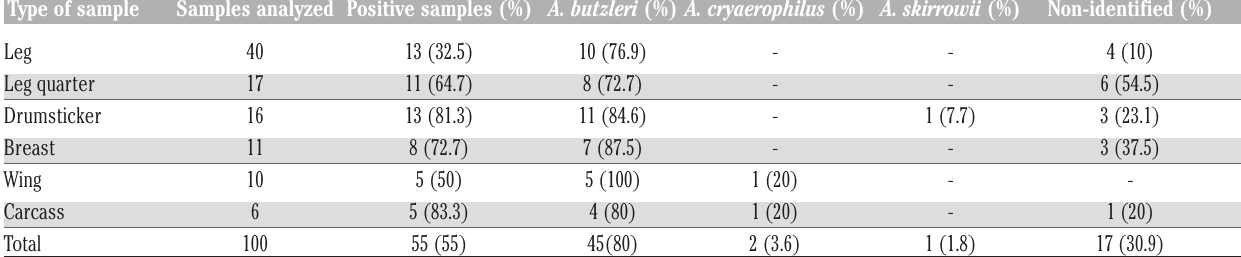
Table 1. Distribution of Arcobacter spp. based on the type of samples. Type of